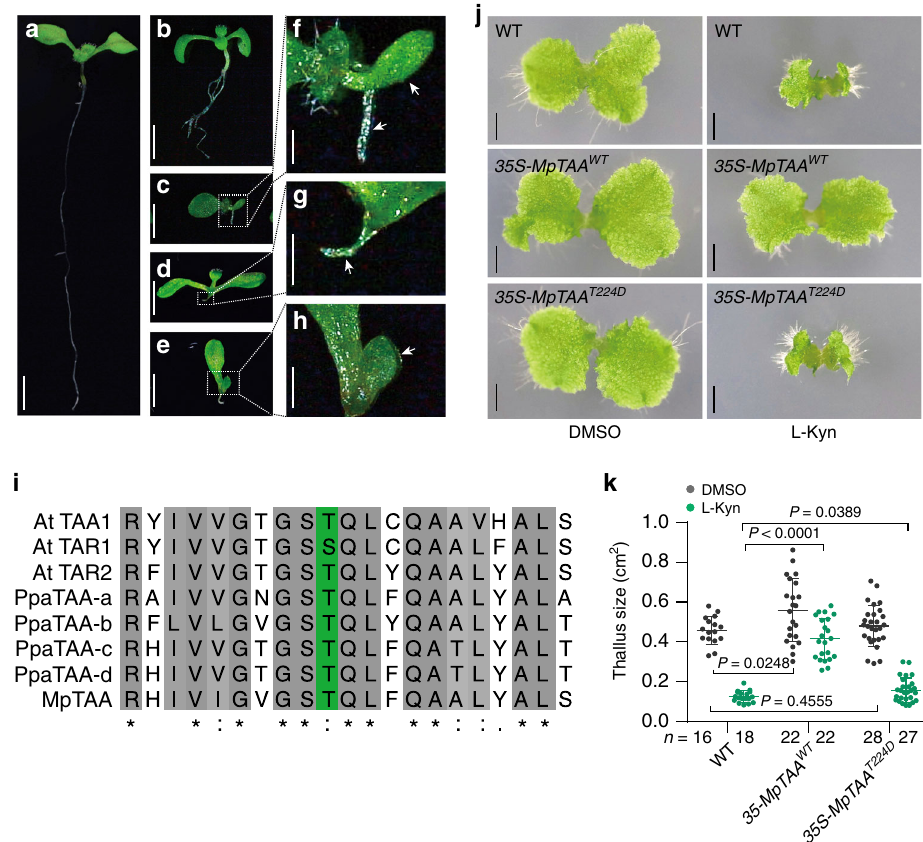
Fig. 2 The function of T101 phosphorylation on AtTAA1 homologs and in TAA1 orthologs during evolution. a – h Representative images of 7-day-old seedling in Col-0 a , wei8-3;tar2-1 b , wei8-3;tar2-2;tar1-1 segregated from wei8-3;tar2-2 crossed with wei8-3;tar1-1 F2 generation c , and 35S-TAA1 T101D ;wei8-3; tar2-1 d , e . Magni fi ed picture of wei8-3;tar2-2;tar1-1 f and 35S-TAA1 T101D ;wei8-3;tar2-1 g , h . 54 out of 342 35S-TAA1 T101D ;wei8-3;tar2-1 seedlings (15.79%) from three independent lines (T2 generation) showed strong phenotype. Source data were provided in the source fi le. The result represents one of two replicates which showed a similar phenomenon. Arrows show asymmetric cotyledons and severe root defects. Scale bar, 0.25 cm a – e ; 40 mm f – h . i Sequence alignment of TAA orthologs among Arabidopsis ( At ), Physcomitrella Patterns ( Ppa ), and Marchantia Polymorpha ( Mp ). Green colour column indicates the conserved residues as the AtTAA1 T101 site. j Phenotype of overexpressing MpTAA WT and MpTAA T101D in wild-type Marchantia (Tak-1) treated with 500 μ M L-Kyn. Images denote representative thalli. Scale bar, 0.2 cm. k Quanti fi cation of the thallus size in j . Gammae from three independent lines of 35-MpTAA WT and two independent lines of 35-MpTAA T224D at 16 day old were quanti fi ed by thalli area. n denotes the number of independent thallus; two-sided t -test. P values were shown as